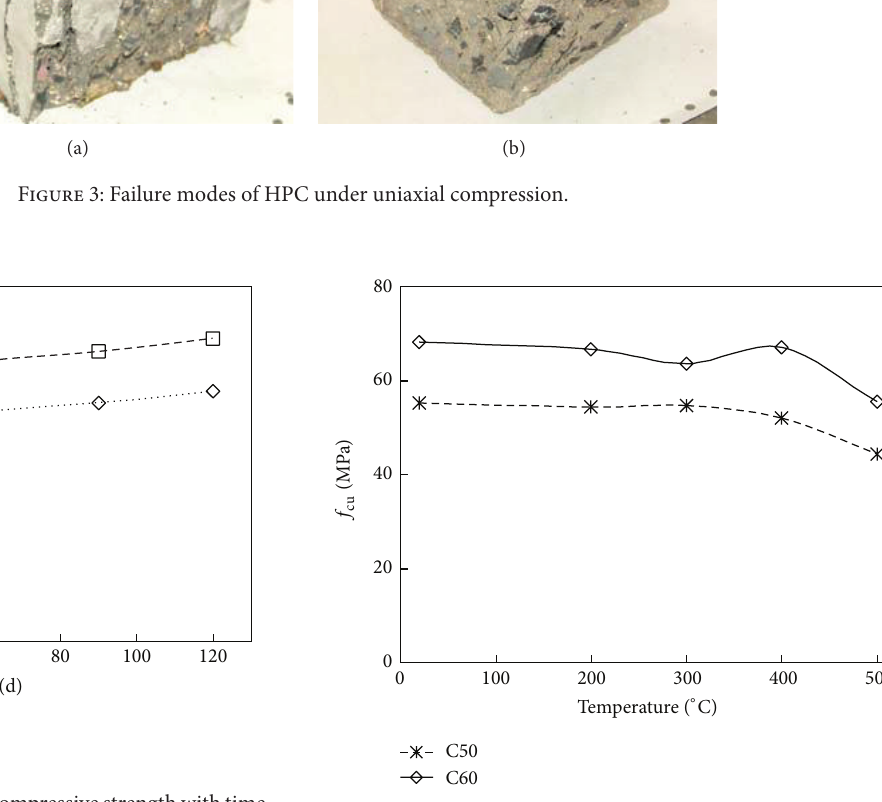
Figure 5: Cubic compressive strength of HPC at elevated tempera-